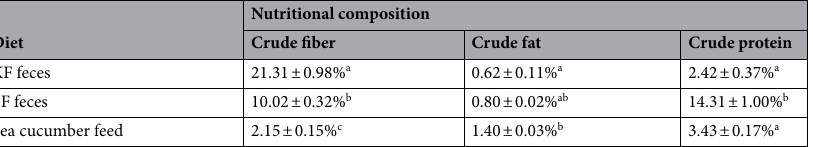
Table 1. The nutritional composition (% dry weight) of the feces of sea urchins fed kelp (KF feces), the feces of sea urchins fed prepared feed (FF feces) and the sea cucumber feed (commercial feed mix with sea mud = 1: 6). Different letters indicates significant differences among the three diet ( P <